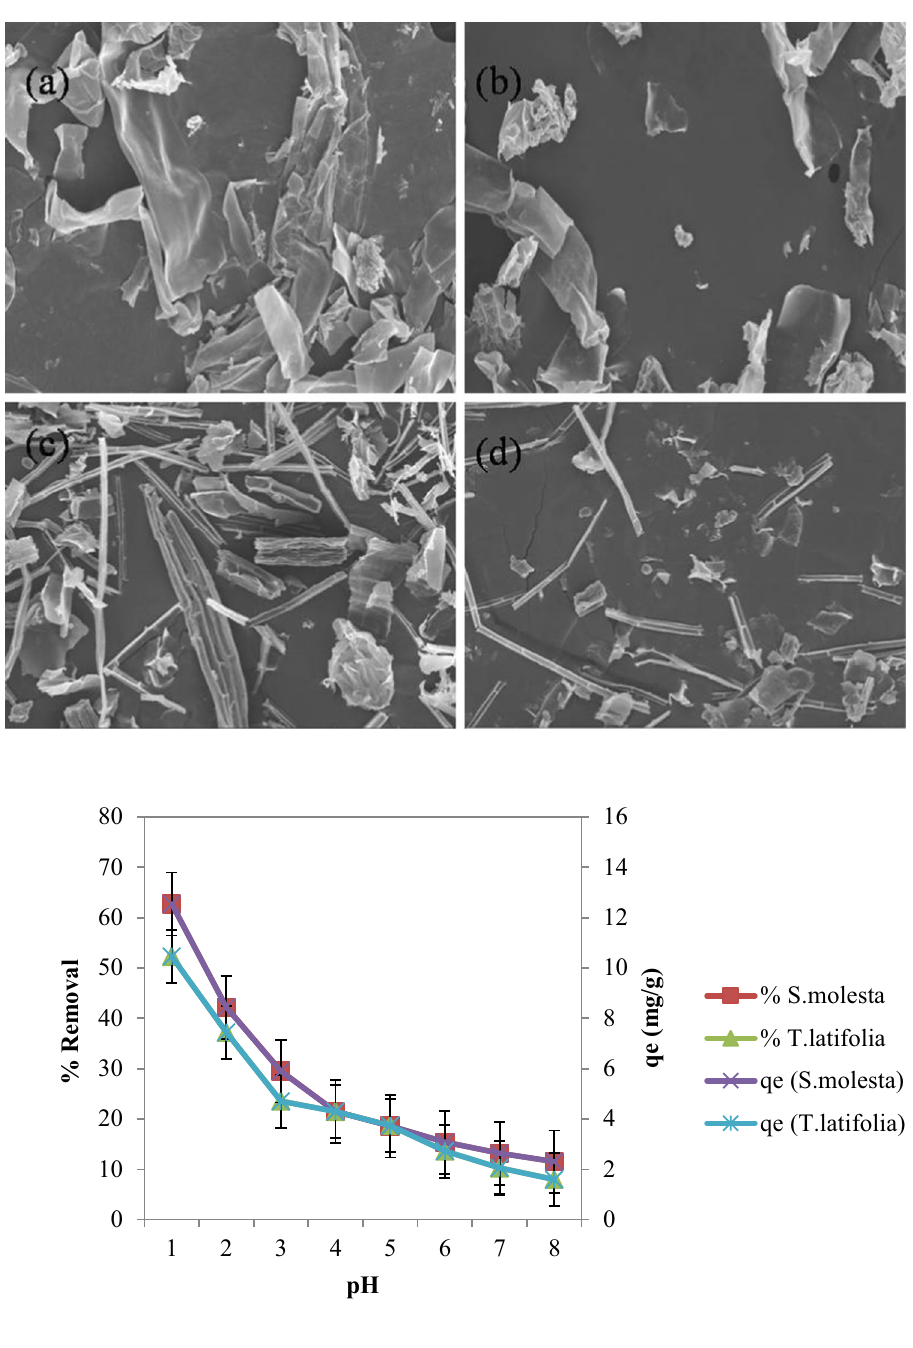
Fig. 2 SEM images (a) before, and (b) after adsorption on S. molesta , (c) before, and (d) after adsorption on T. latifolia